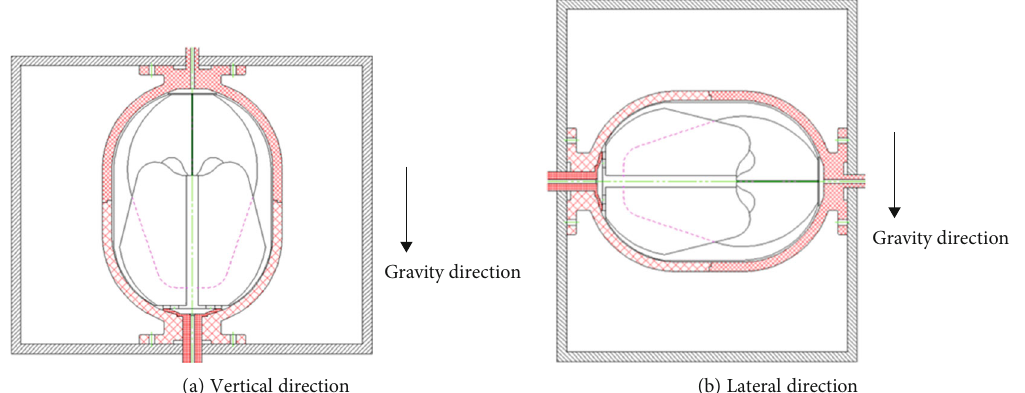
Figure 4: Di ff erent directions for the test.